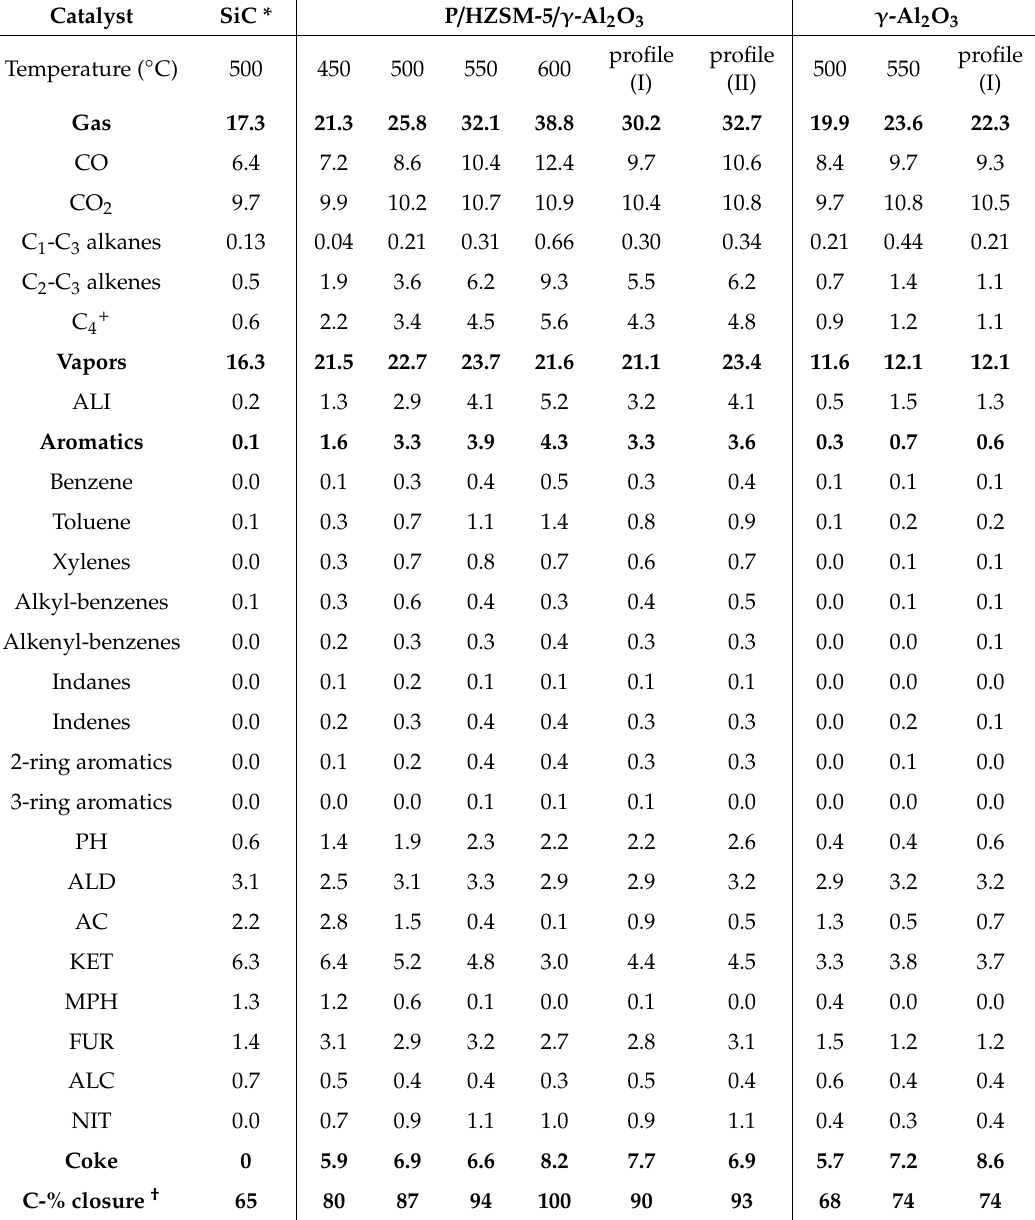
Table 2. Cumulative carbon yield of products (wt% C of fed biomass carbon) for a final B:C ratio of ~4 (integration of 16 vapor pulses). The major product groups, i.e., gas, vapors, and coke are shown in bold. In addition, the detailed composition of the yield of aromatics is shown (from benzene to 3-ring